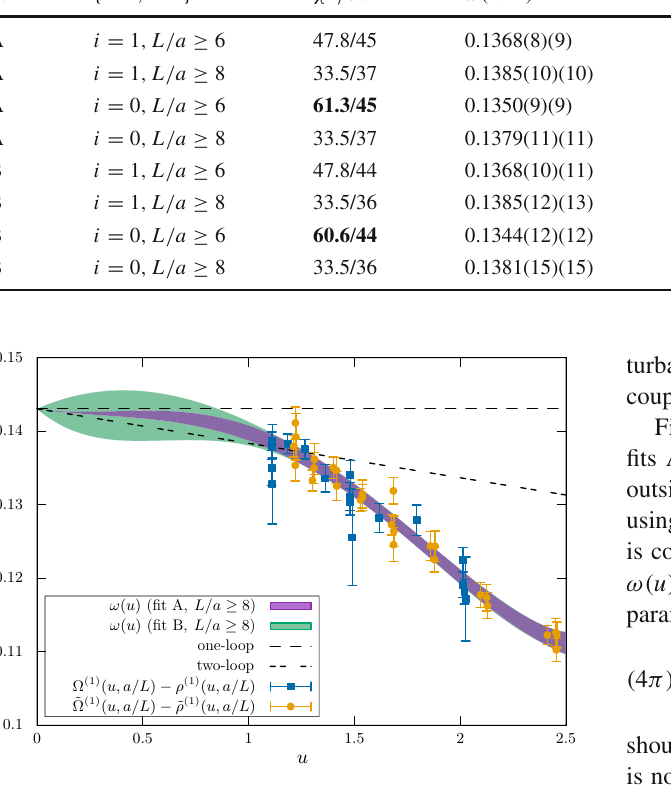
Fig. 3 The bands show the continuum fit functions for fits of type A and B to one-loop improved data for L / a ≥ 8 and the data points are one-loop improved data with the cutoff effects subtracted using the models ρ ( 1 ) ( u , a / L ) and ˜ ρ ( 1 ) ( u , a / L ) from the type A